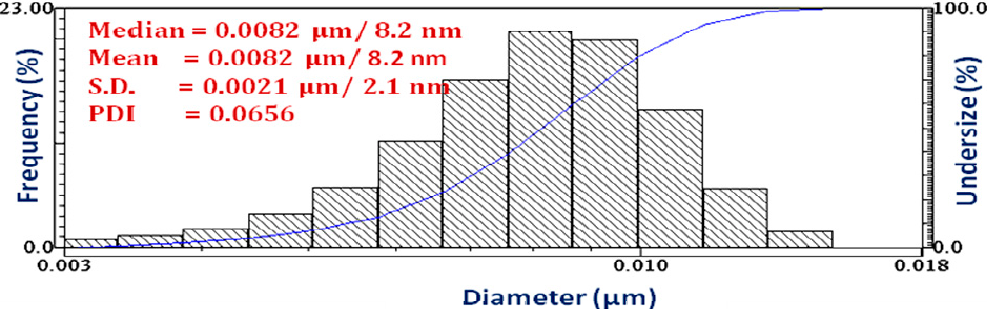
Figure 4. DLS size distribution of the Cu 2 O nanoparticles. Abbreviations: DLS, dynamic light scattering.